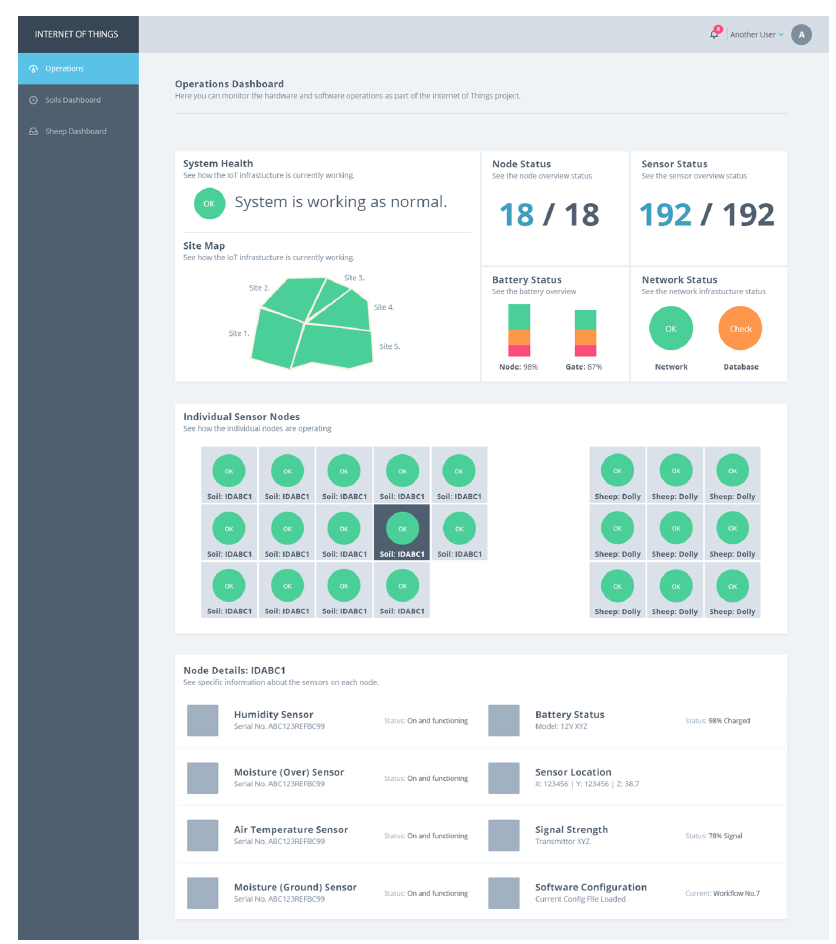
Figure 10. Environmental IoT dashboard